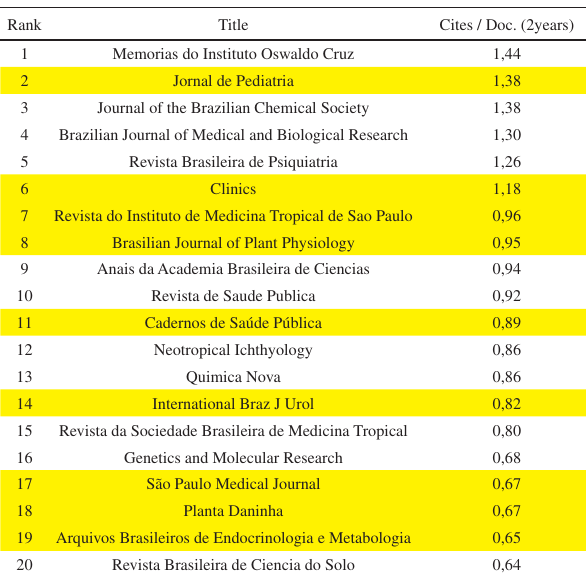
Table 1 - Top 20 (out of 153) Brazilian Journals in the Sci- mago ([Cites/Doc] rank. Highlighted in yellow are Journals excluded from ISI - Thomson.